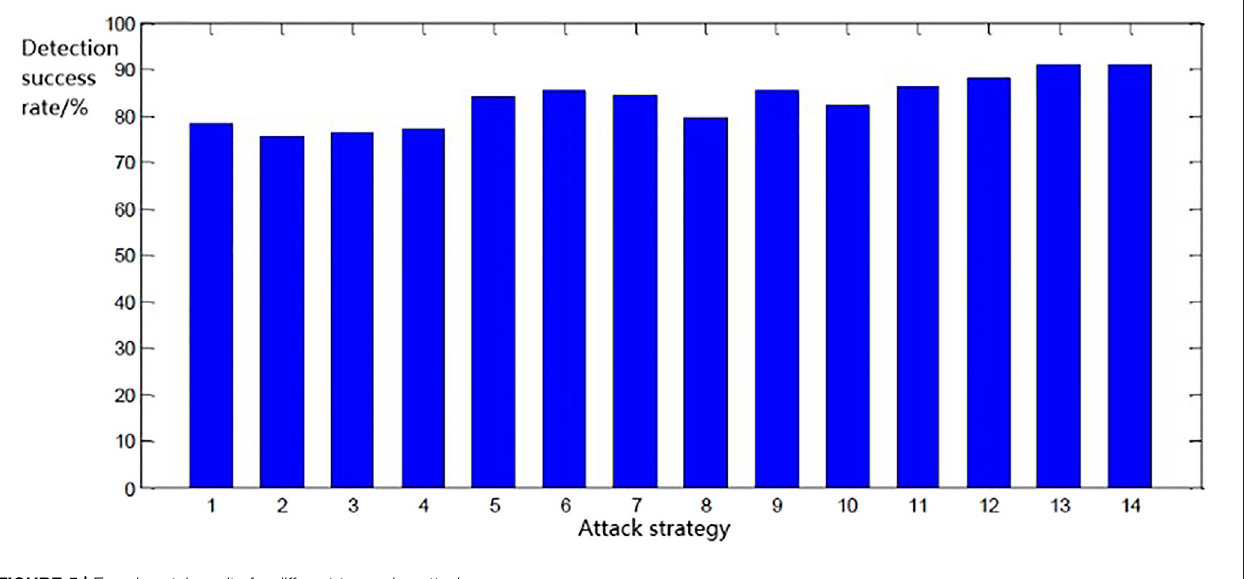
FIGURE 5 | Experimental results for different tampering attacks.